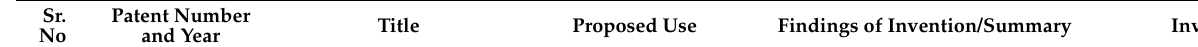
Table 7. Exploring the potential of thermosensitive hydrogels through